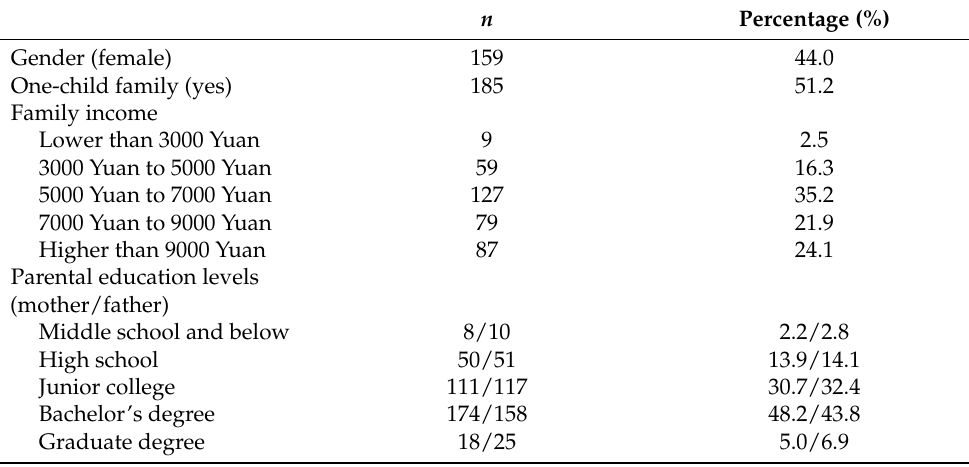
Table 1. The sample